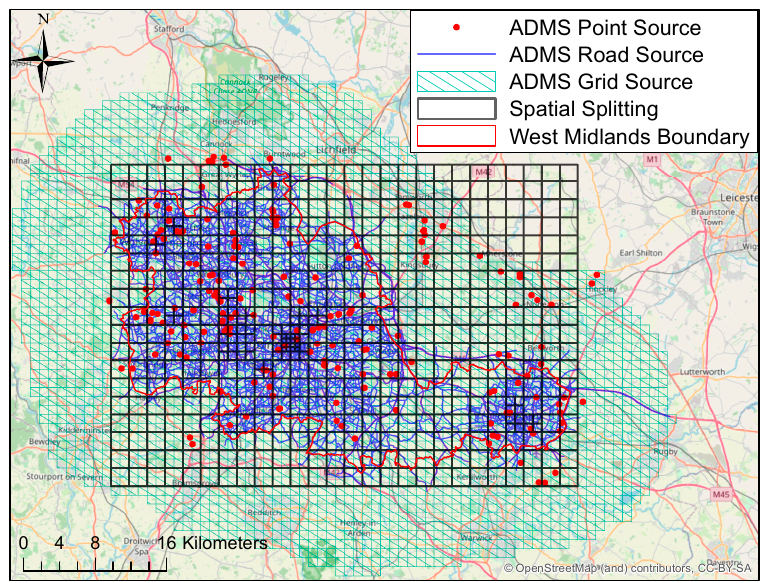
Figure 2. Emission sources in the model and spatial splitting for the modelling domain over West Midlands. Table 1. Overview of total emissions (in tonnes/year) for different sources over the WM computa- tional domain.